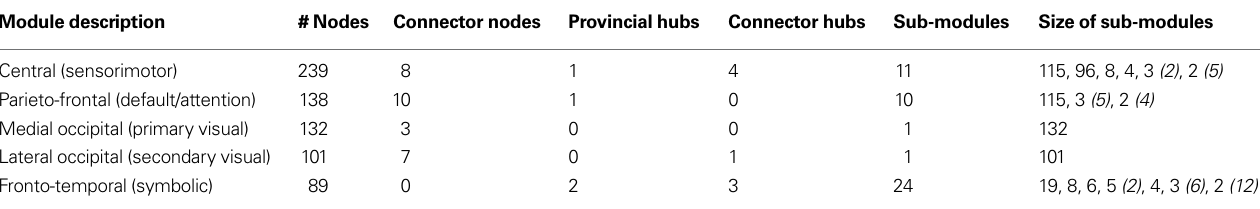
Table 1 | The fi ve largest modules of the human brain functional network in a representative normal volunteer, indicating the number and type of nodes and